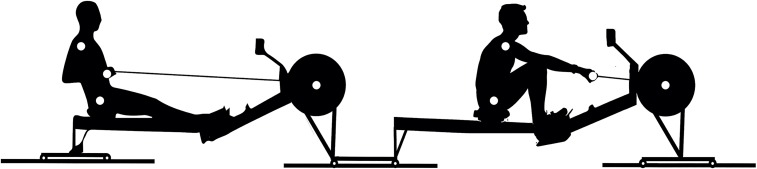
Experimental Setup.Note that only the markers placed on the right side are shown. See also S1 Movie and S2 Movie for exemplary movies.